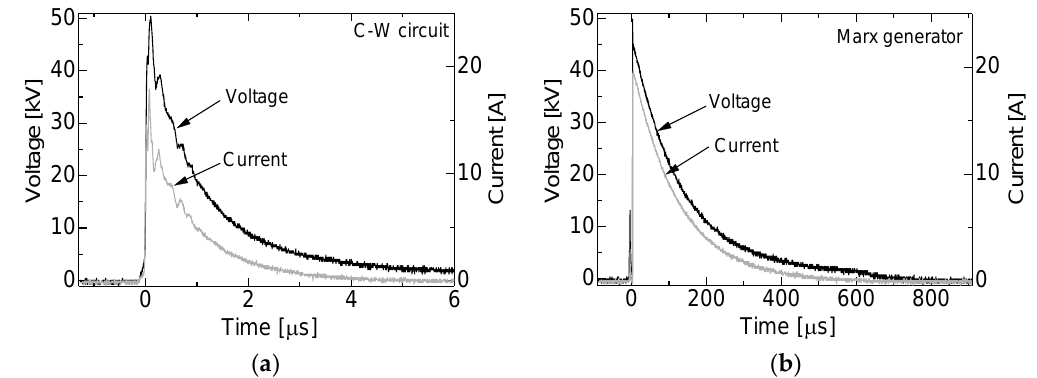
Figure 8. Typical waveforms of applied voltage and current to the L. edodes logs using ( a ) C-W circuit and ( b ) Marx generator.